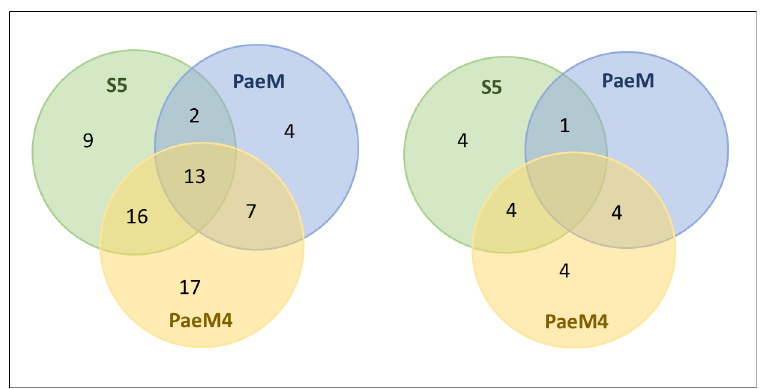
Fig 4. Sensitivity of clinical isolates to three plant-expressed pyocins. Venn diagramdescribingpyocin susceptibilitiesof clinical Pseudomonas aeruginosa isolates. Left–susceptibility of all 100 tested isolates, right–susceptibilityof 21 antibiotic-resistant